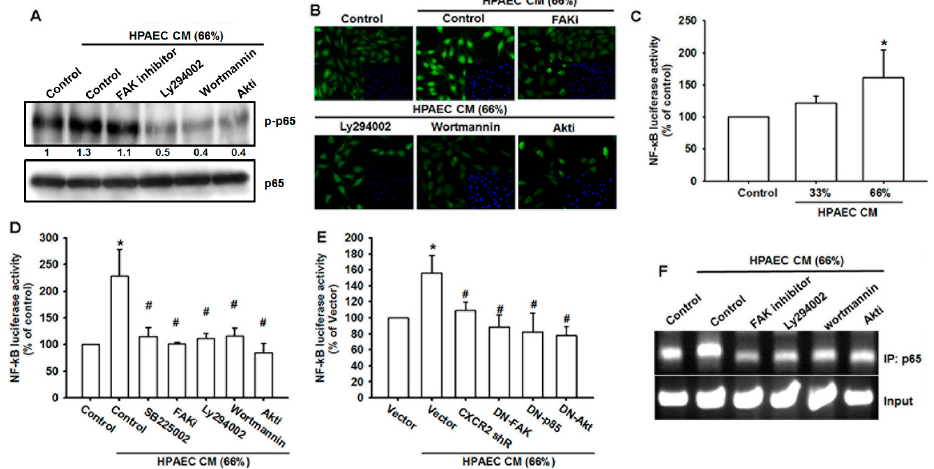
Figure 6. NF- κ B transcriptional activation is required for cell mobility and VCAM-1 expression in osteosarcoma cells incubated with HPAECs CM. ( A ) MG63 cells were pretreated with pathway inhibitors (FAKi, LY294002, Wortmanin, Akti, TPCK, and PDTC) for 90 min and then incubated with HPAECs CM for 1 h. p65 activation was evaluated by Western blot. ( B ) MG63 cells were treated as described in (A) and then subjected to immunofluorescence by anti-p65 antibody staining. Nuclei were counterstained with DAPI (4 ′ ,6-diamidino-2-phenylindole). Representative microscopy images are shown. ( C ) MG63 cells were transfected with NF- κ B reporter vector for 24 h and then incubated with di ff erent concentrations of HPAECs CM for 24 h. NF- κ B transcriptional activity was